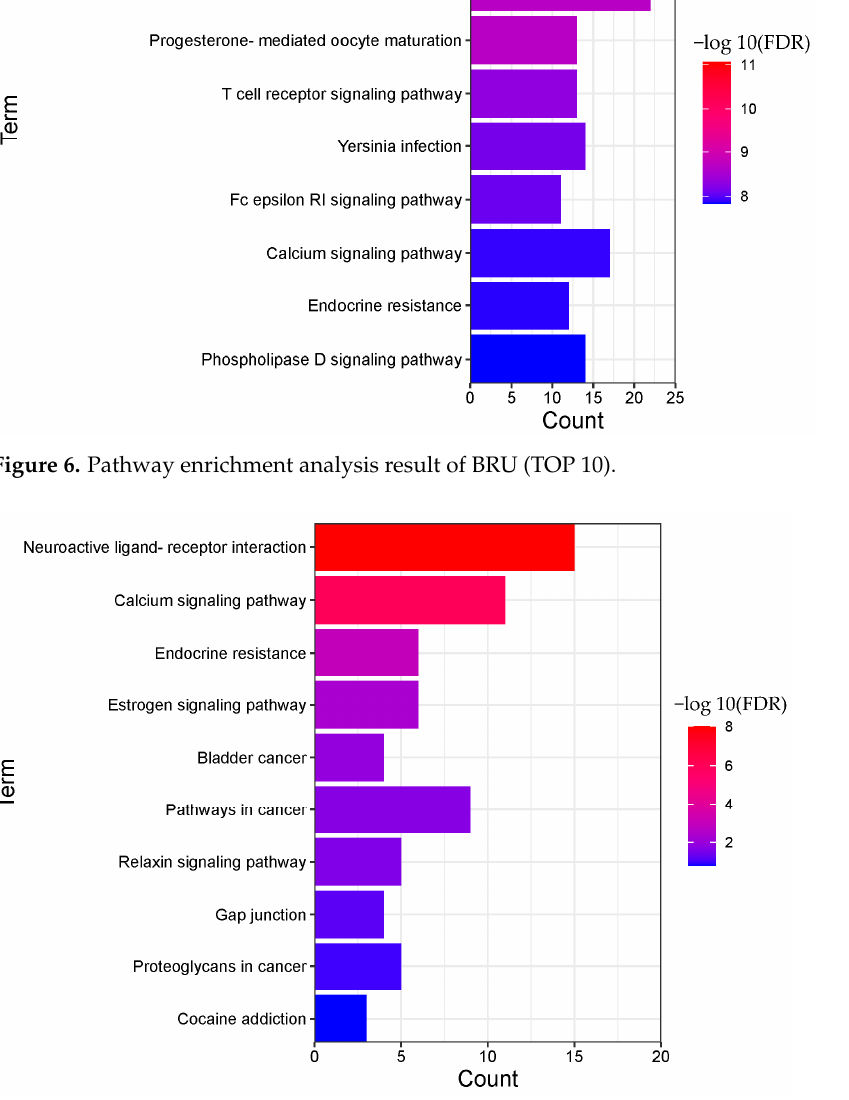
Figure 7. Pathway enrichment analysis result of BNO (TOP 10).